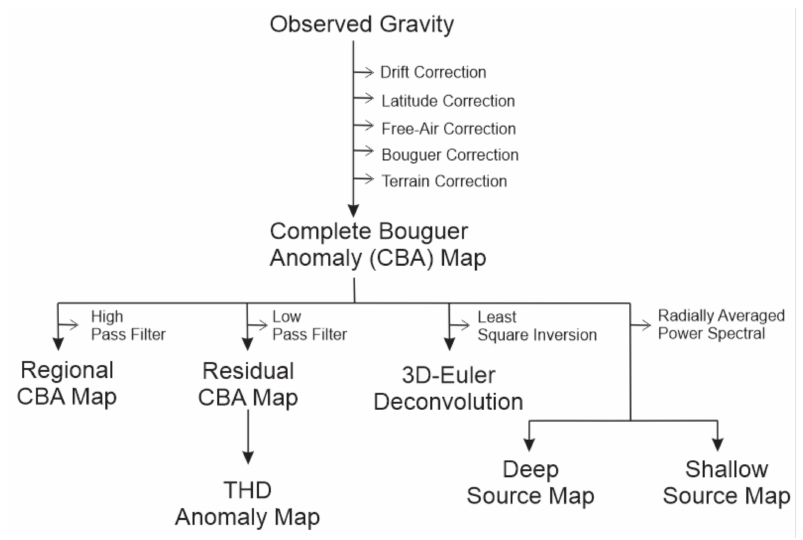
Figure 5. A workflow diagram for gravity anomaly maps. The horizontal arrows indicate the analyzes while the vertical arrows indicate the